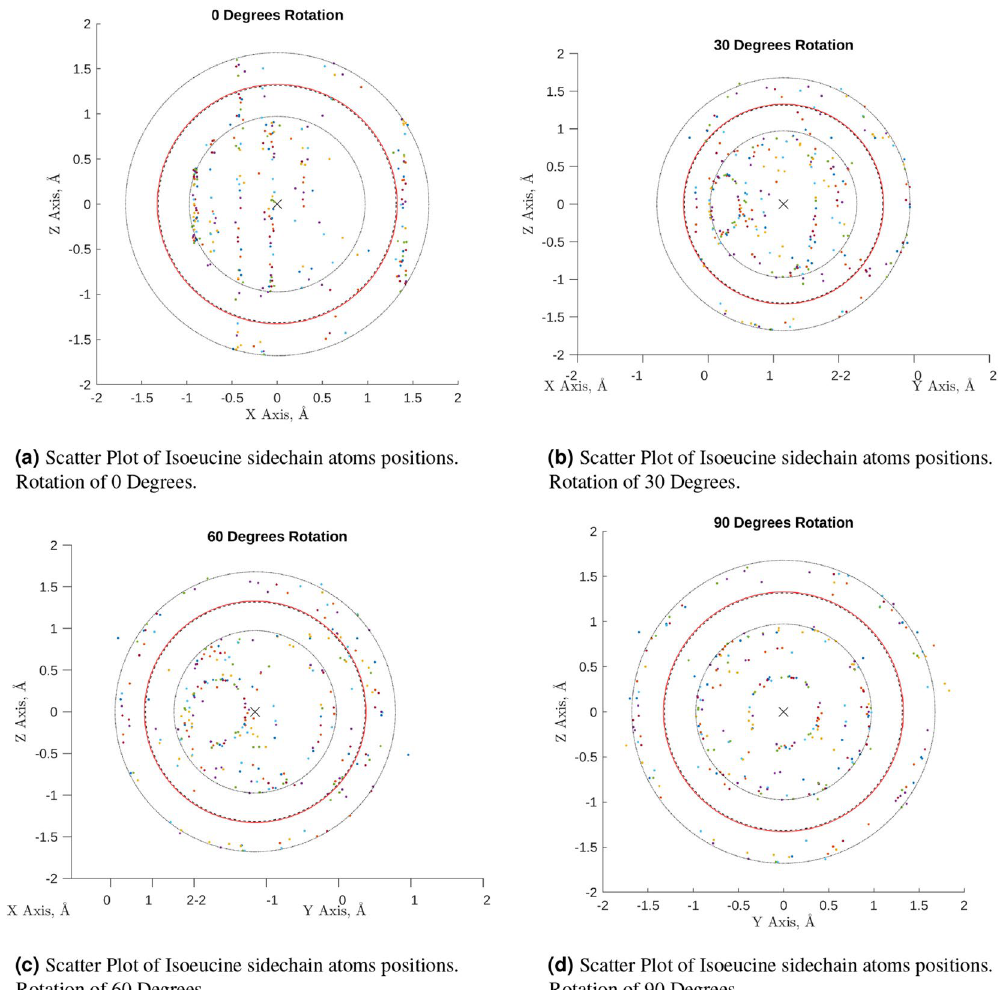
Figure 5. ( a – d ) The above scatter plots show the overlaid positions of the sidechain atoms from each alpha- helix in talin’s rod domain. Each plot shows a subsequent rotation around the Z axis of the view of the figure. The positions were first normalised with respect to their C α atom position and then their orientations were aligned using the line between the average sidechain atom position and the C α atom position. The red circle represents the mean Euclidean distance from the centre of the collection of sidechain positions to each individual atoms position. The dashed line represents the median distance, the inner dotted line represents the first inter-quartile and the outer dotted line represents the third inter quartile. (MATLAB, 2020b, https:// www. mathw orks.